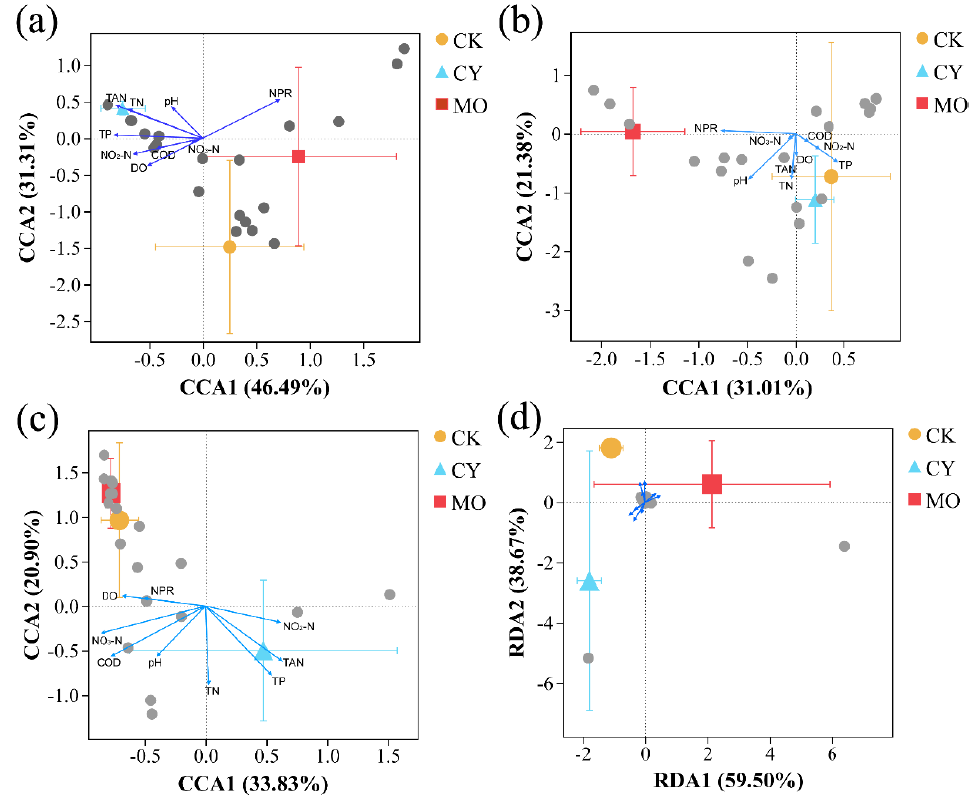
Figure 5. Correlation analysis of environmental factors and the relative abundance of top 20 abundant ( a ) bacterial, ( b ) phytoplankton, ( c ) zooplankton, and ( d ) fungal species.